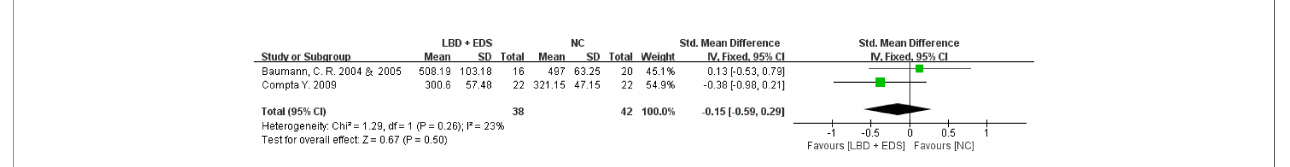
FIGURE 3 | Forest plots of the CSF orexin-A levels in LBD with EDS compared with NCs. CSF, cerebrospinal fl uid; LBD, Lewy body disease; NCs, normal controls; EDS, excessive daytime sleepiness; CI, con fi dence interval.